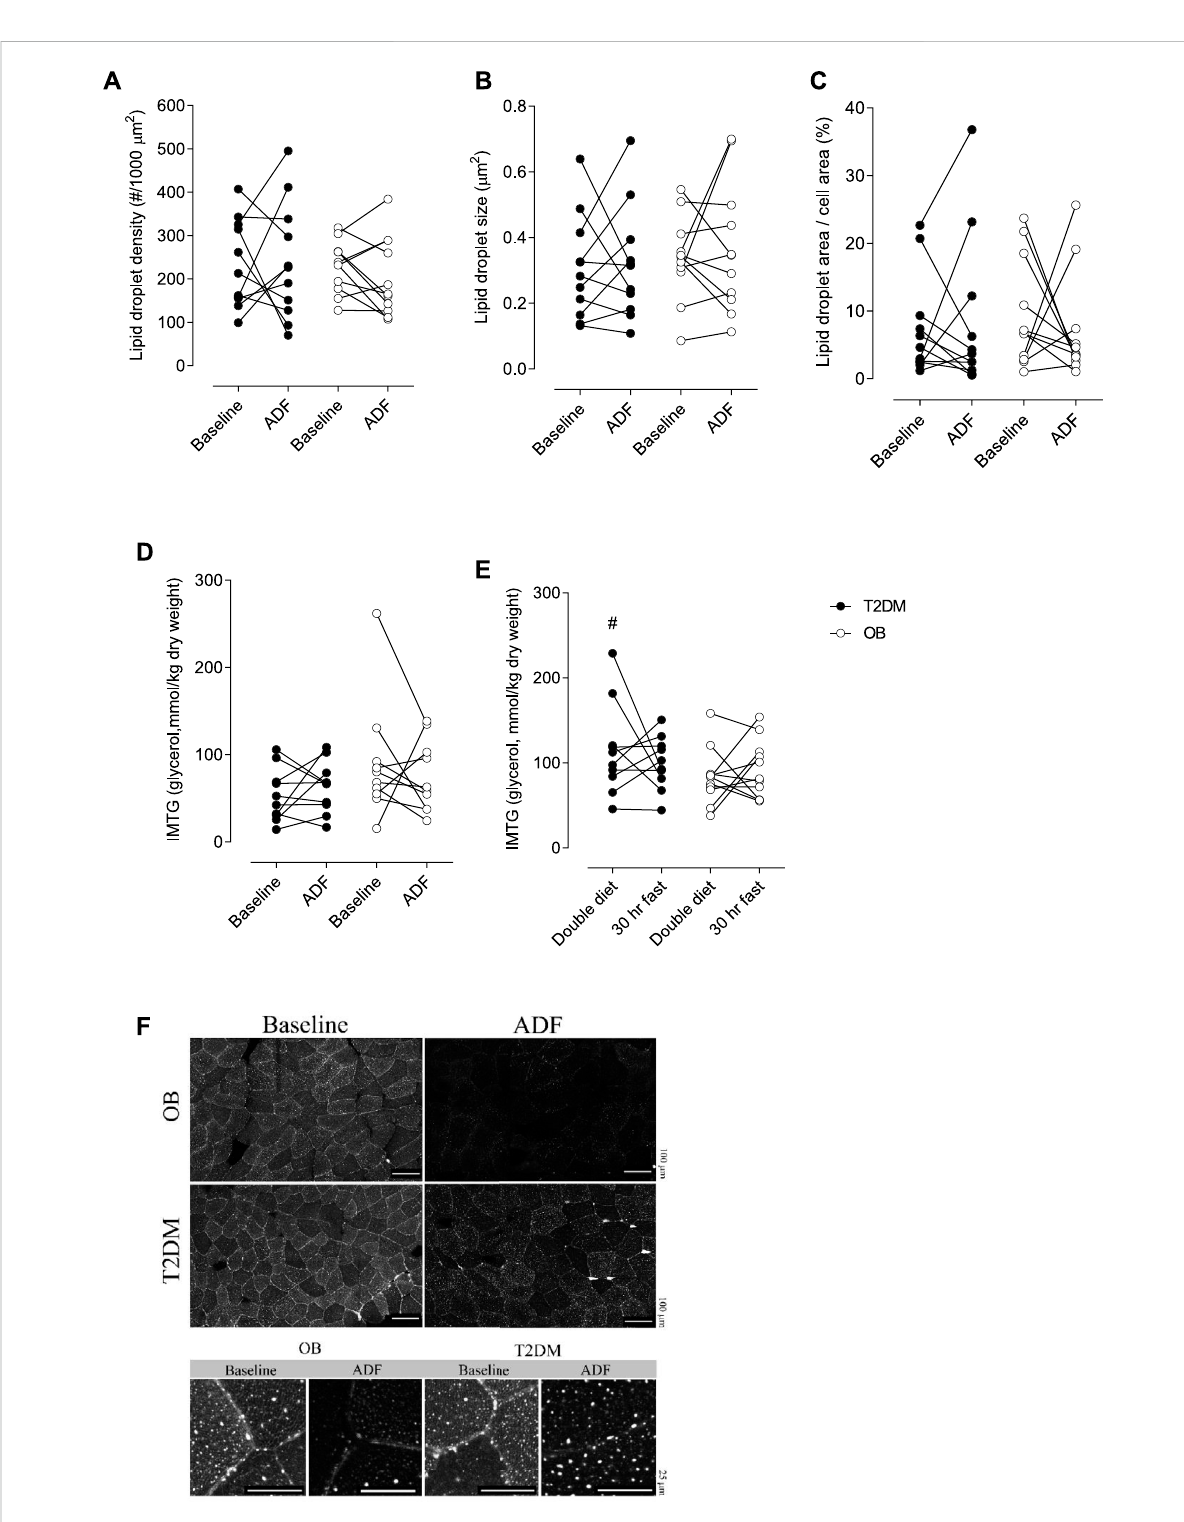
FIGURE 5 Lipiddroplets(LD)densityperareaofmuscle fi bre (A) .LDsize (B) .FractionalareaofLDs ’ (C) .Intramusculartriglyceride(IMTG)contentinmuscle at baseline clamp and at the clamp after ADF (D) . IMTG content in muscle after one double diet day and after 30 h fasting (E) . Representative images of Bodipy staining (F) . OB, Obese subjects, T2DM, patients with type 2 diabetes. In fi gure f, scale bars represent 100 µm (top) and 25 µm (bottom). # denotes different from baseline in Figure 4E ( p =